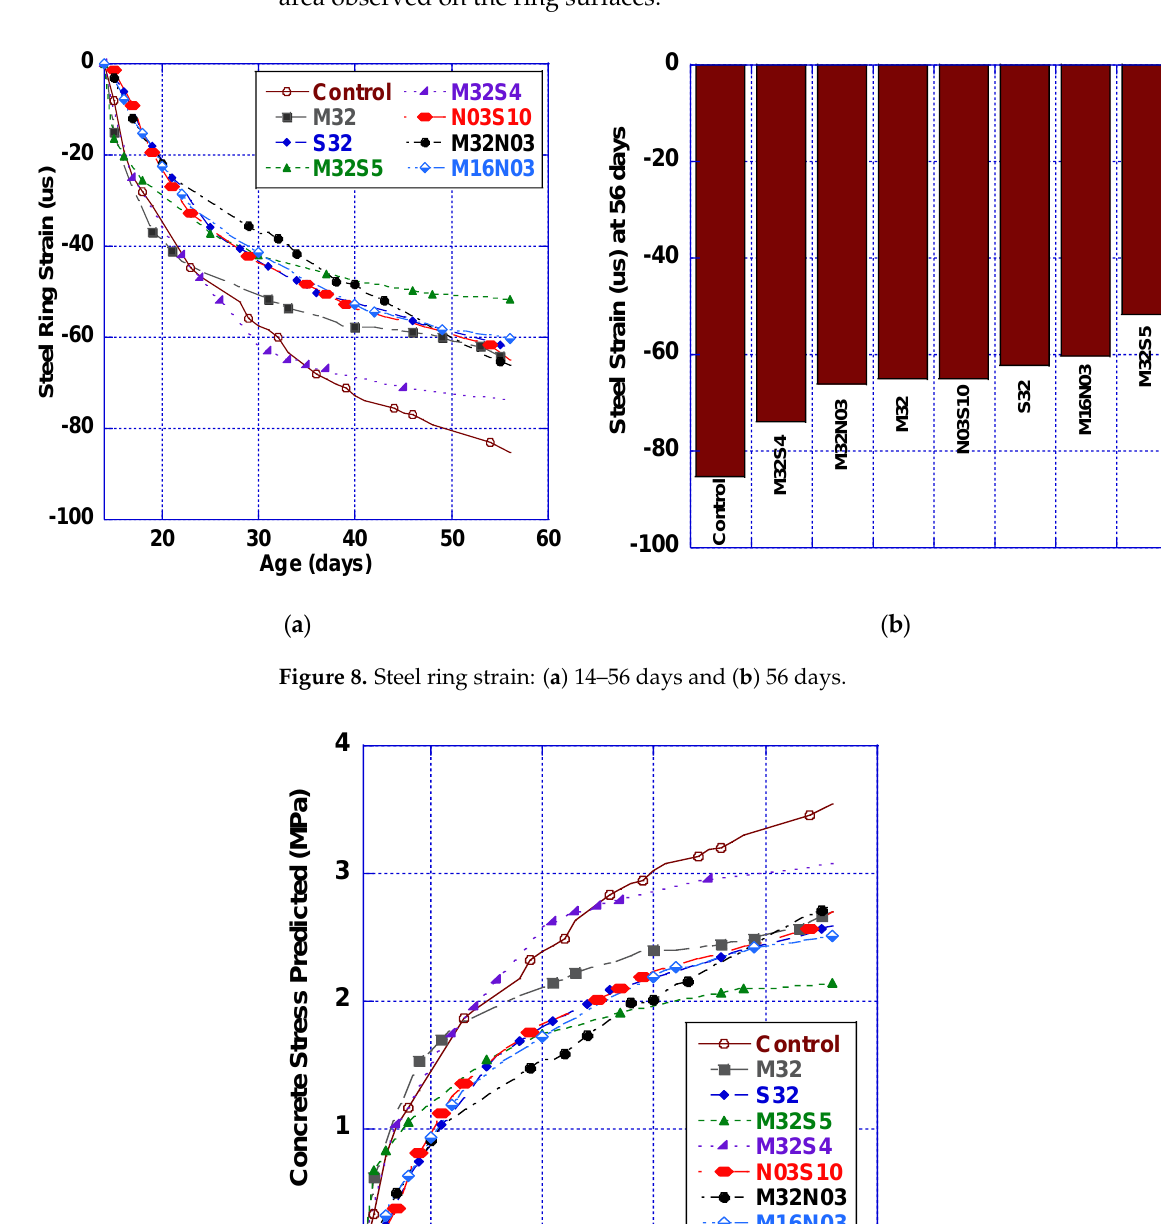
Figure 9. Prediction of the concrete stress using Hossain and Weiss ’s prediction model [42].